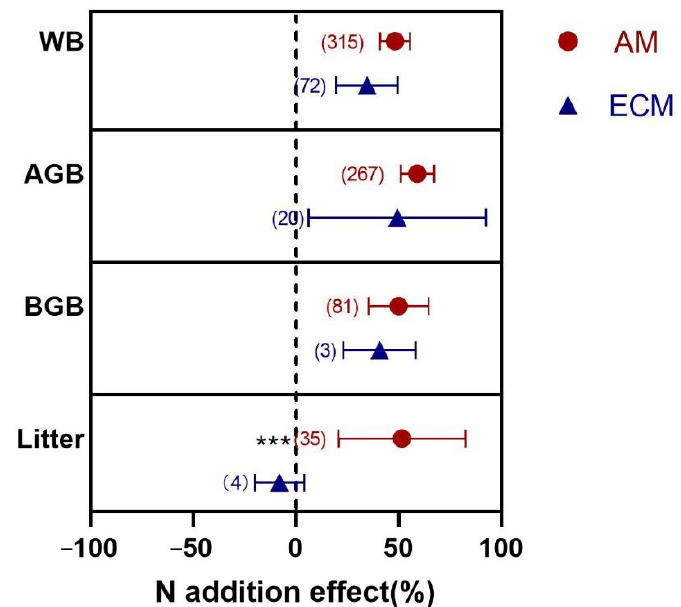
Figure 1. Effects of N addition on WB, AGB, BGB, and litter biomass of AM and ECM plants. AM means arbuscular mycorrhizal type with typical AM structures. ECM means ectomycorrhiza type with typical ECM structures. The symbols represent the average of the 95% confidence intervals (CIs). The effect is considered to be significant when the 95% CI does not overlap with zero. The chi-square test was used to test the heterogeneity of all index effects between AM and ECM plants (*** p < 0.001). WB, whole plant biomass; AGB, aboveground biomass; BGB, belowground biomass. The numbers in parentheses represent the sample size of observations.